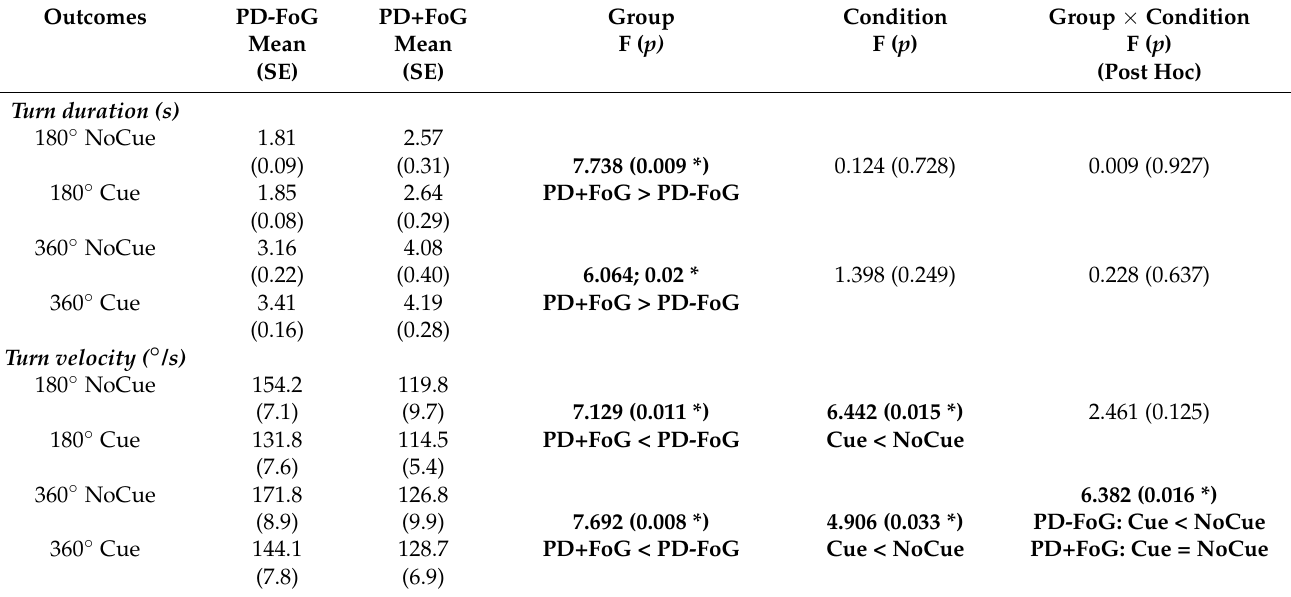
Table 3. Turn outcomes for PD groups (PD-FoG vs. PD+FoG) and condition, with results from the liner mixed effects models while controlling for disease severity